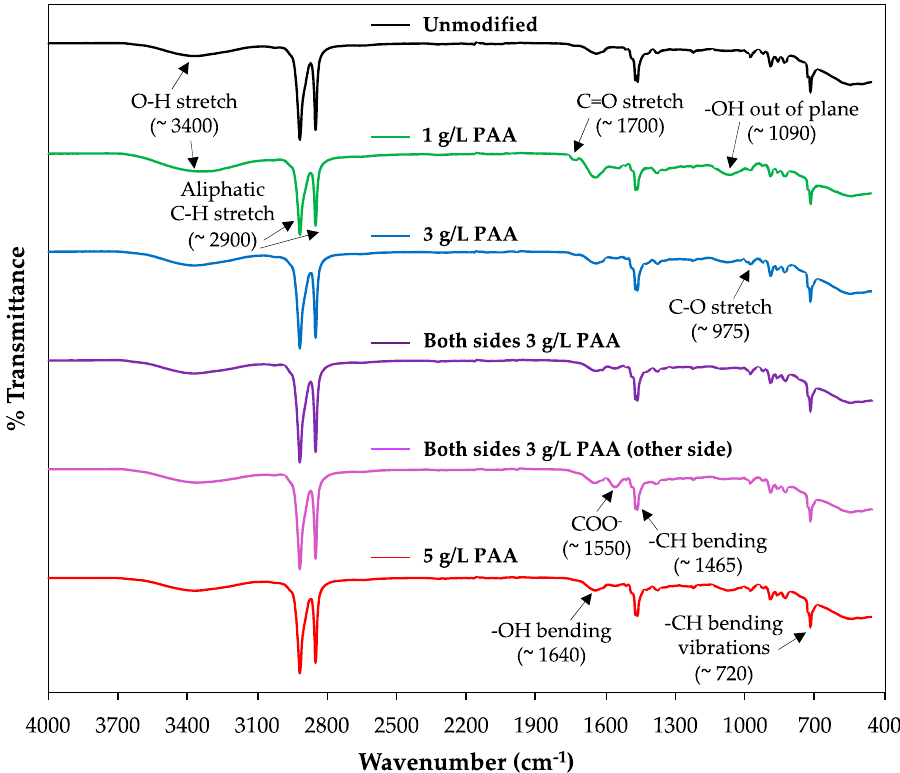
Figure 4. Fourier attenuated atomic force microscopy ( ATR-FTIR ) spectra of unmodified and poly(acrylic) acid (PAA)-modified AEMs.